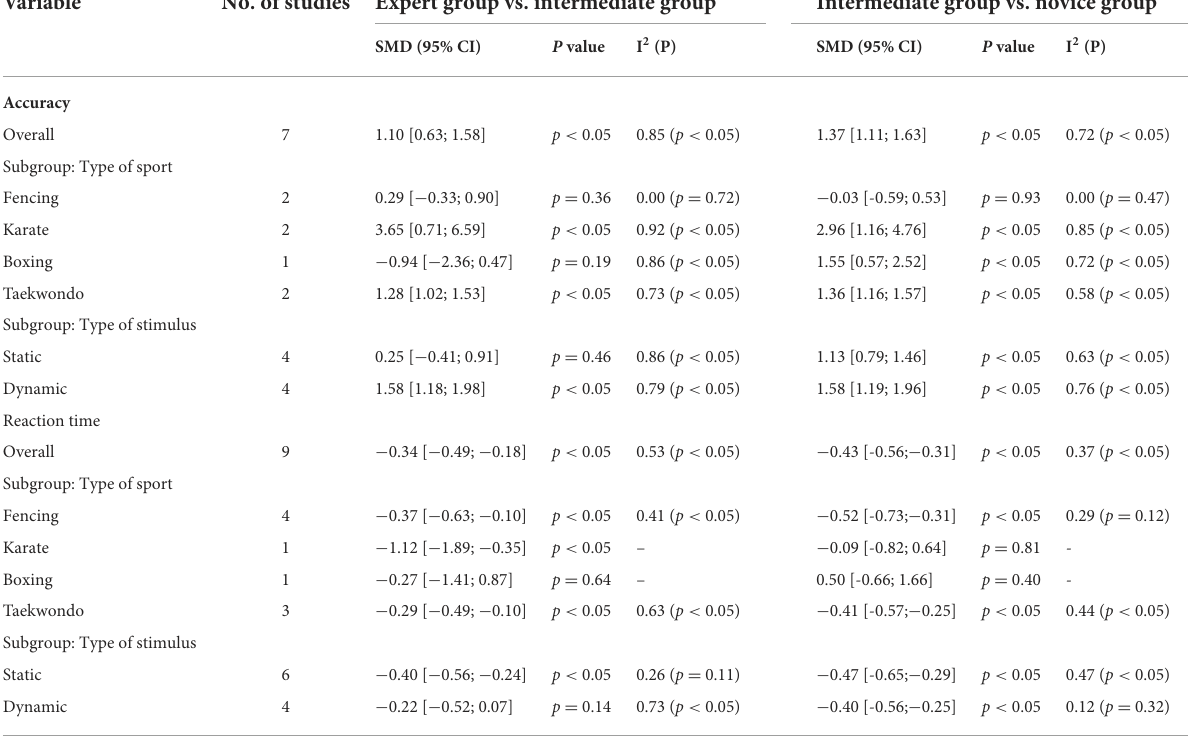
TABLE 3 Analyses of standardized mean differences between the expert, intermediate, and novice groups. Variable No. of studies Expert group vs. intermediate group Intermediate group vs. novice